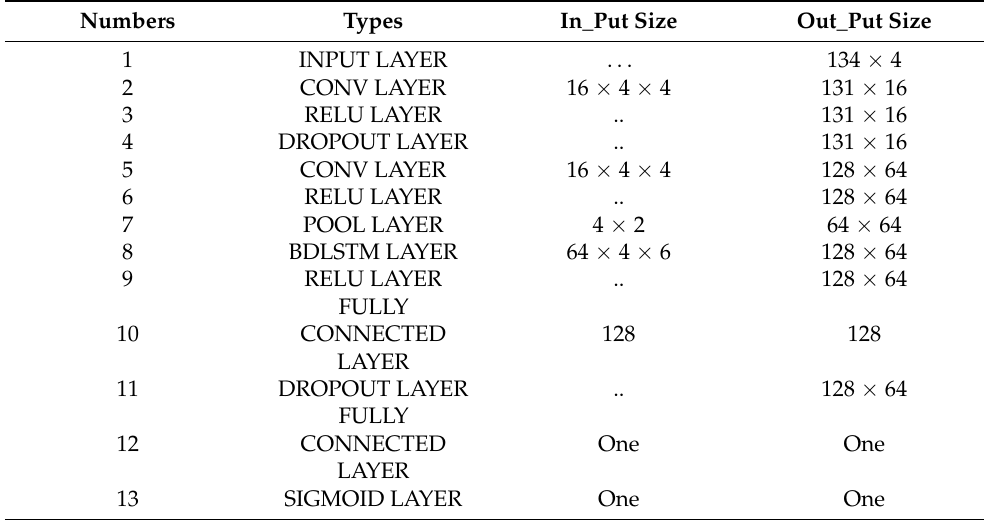
Table 1. The ac4C-DL model layer architecture and output layer